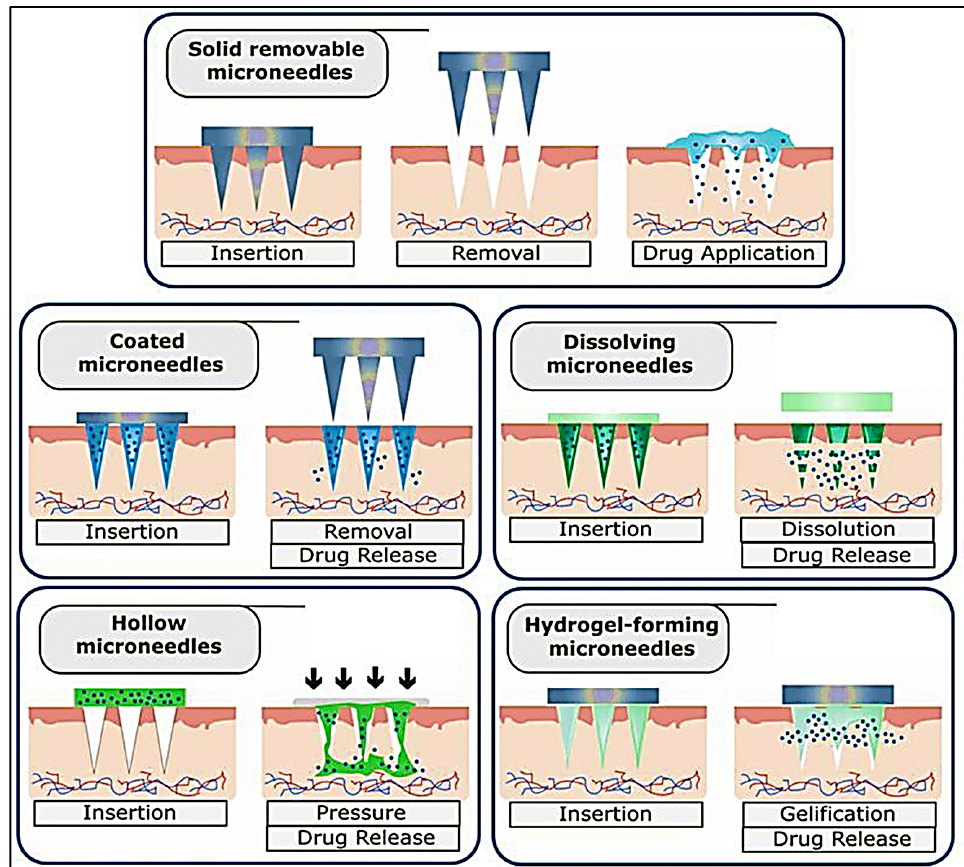
Figure 4. Different types of microneedles employed in the controlled delivery of immunotherapeutic drugs [82]. Reproduced with permissions from Hamed Amani et al., Journal of controlled release , Elsevier, 2021.